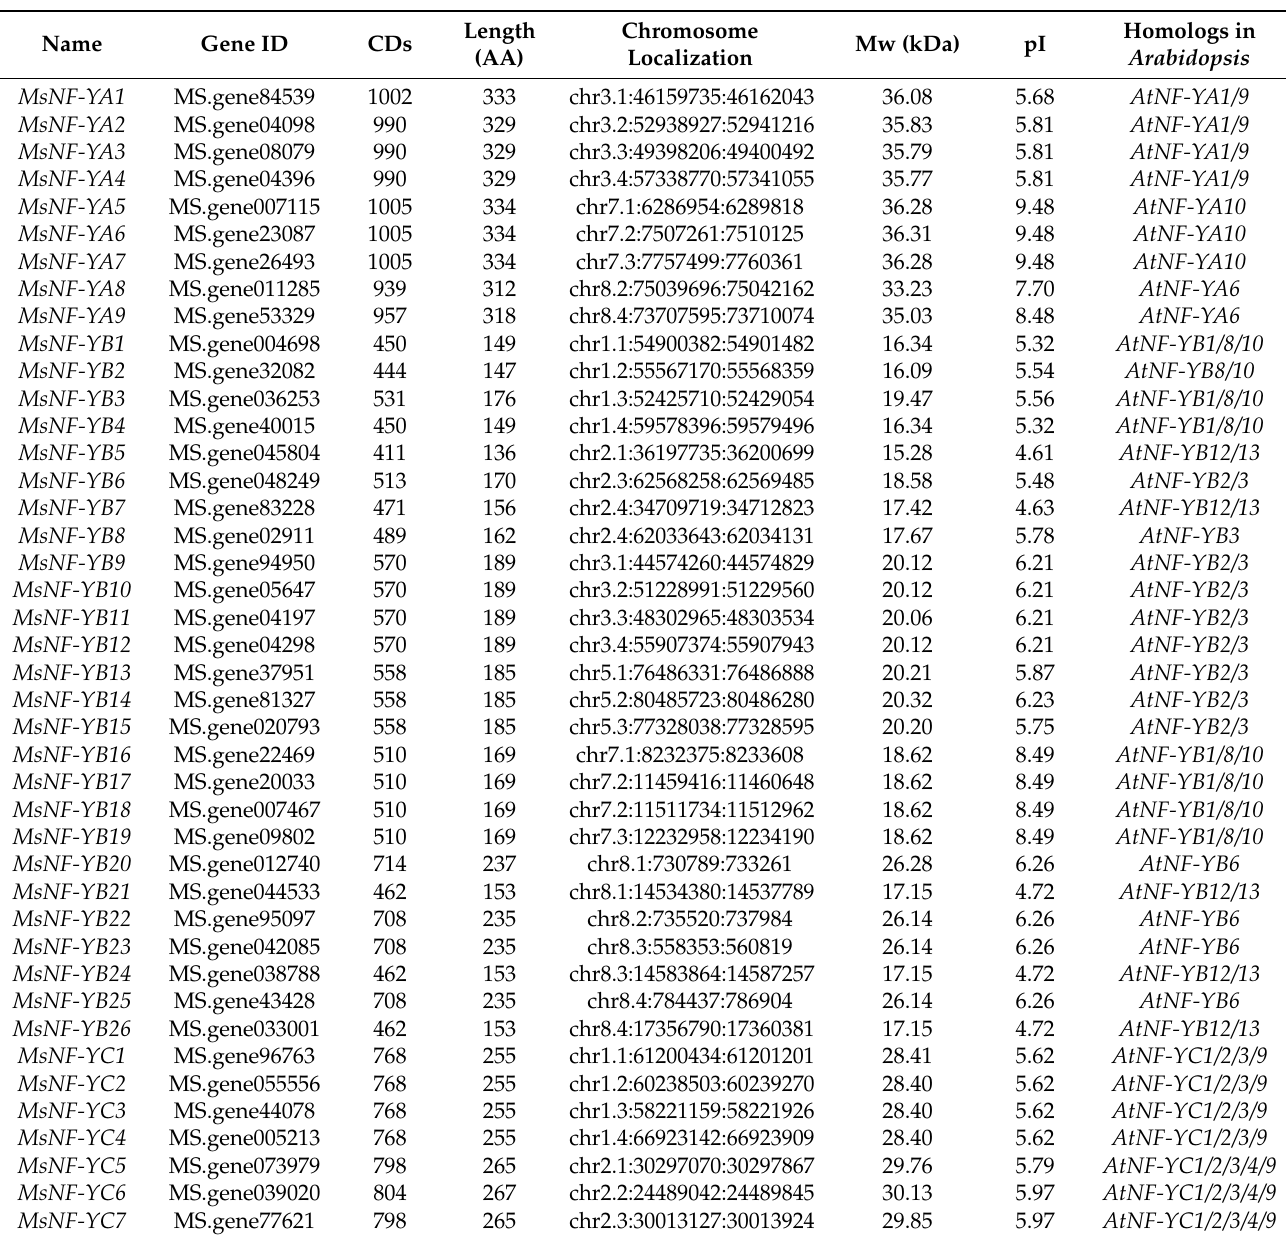
Table 1. Information of the MsNF-Y genes in